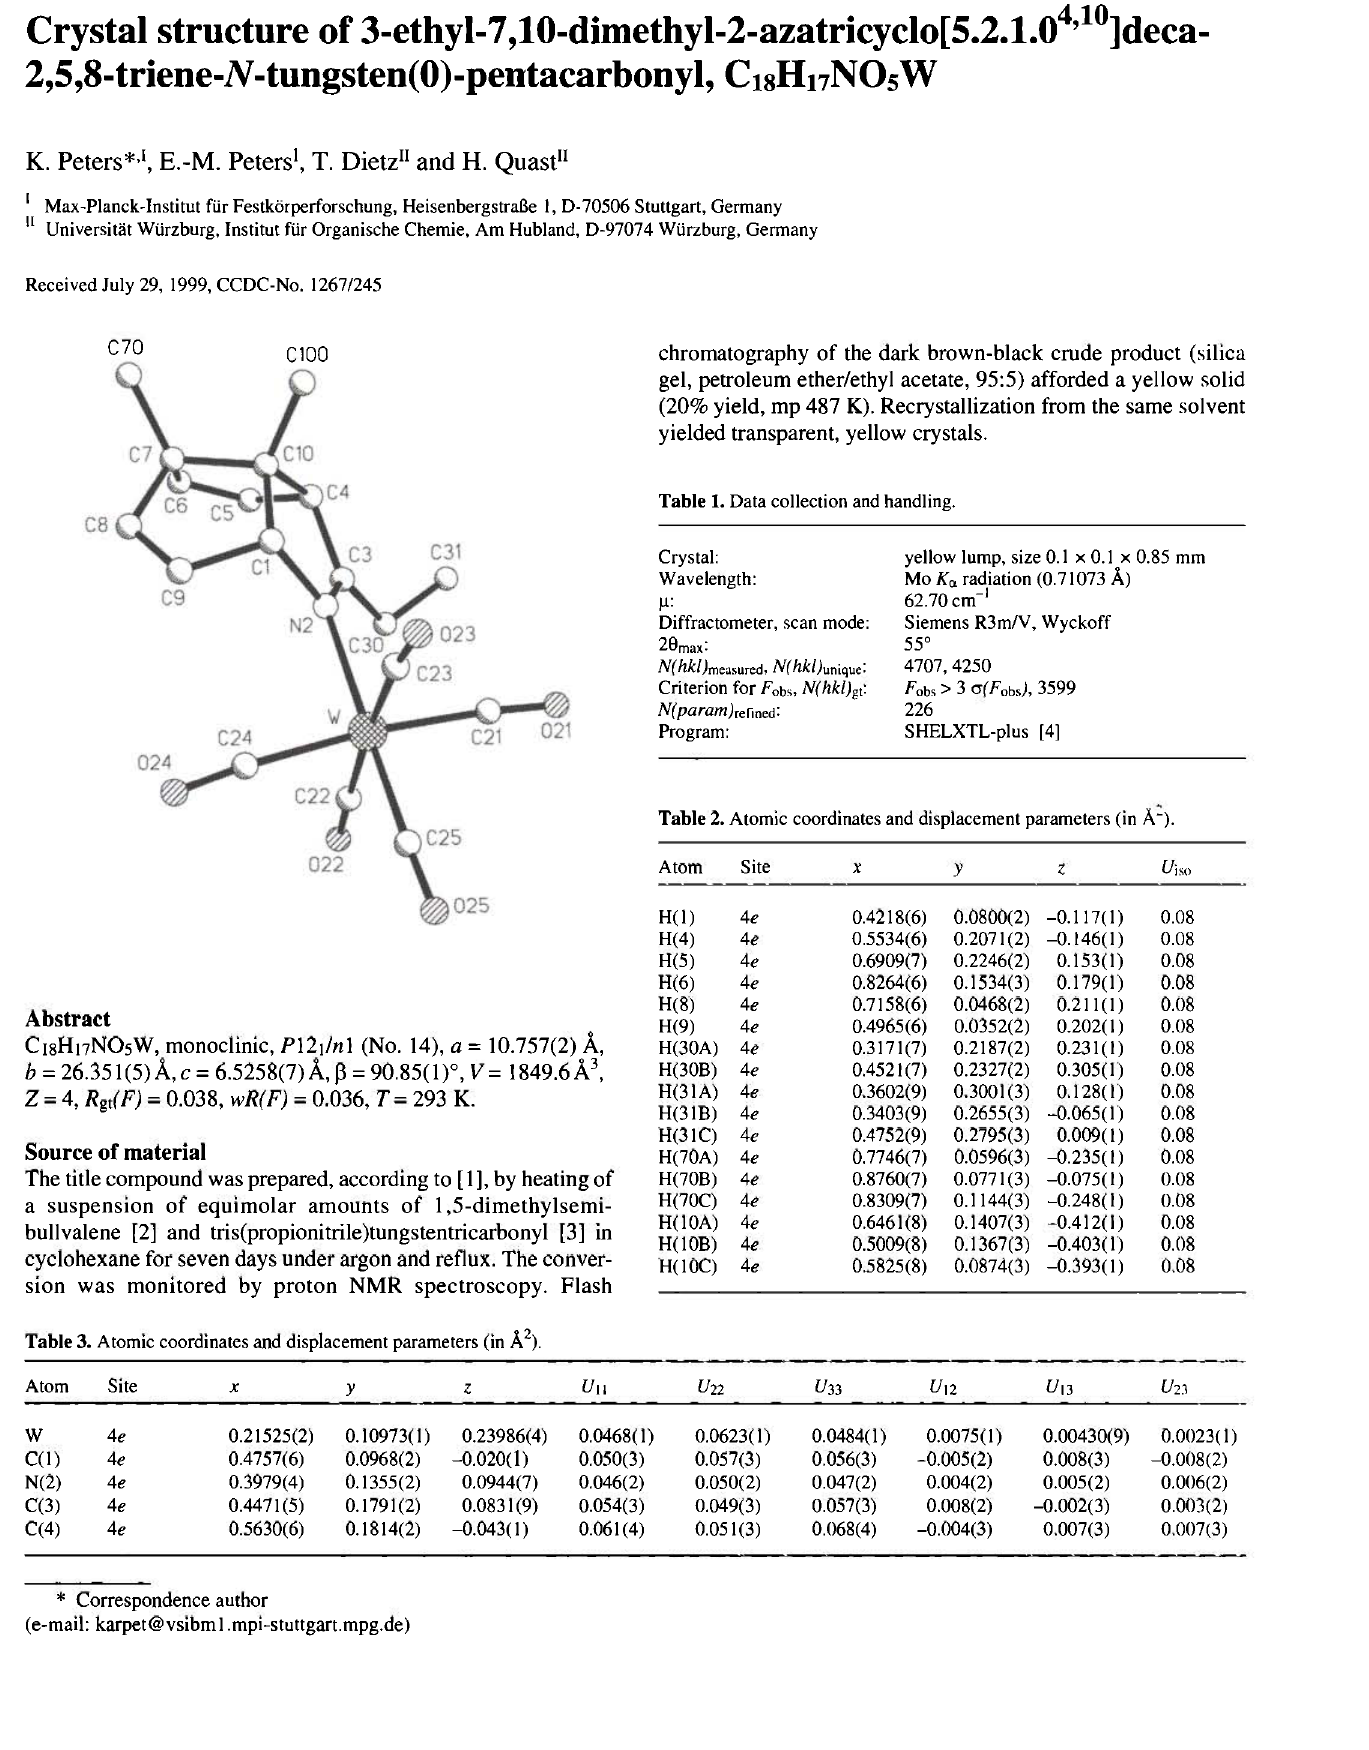
Table 1. Data collection and handling.